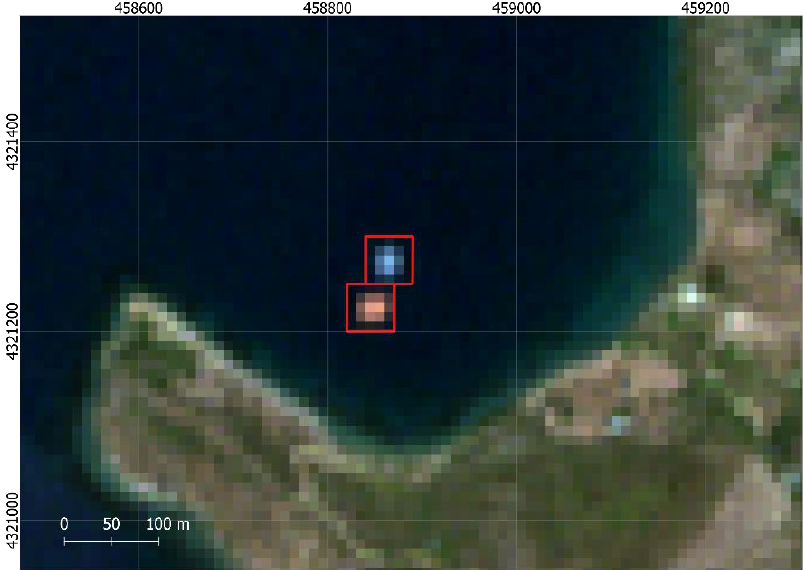
Figure 2. Sentinel-2 cut-out of the PLP2021 deployment area showing the HDPE and wooden planks targets with the corresponding 5 × 5 pixel averages used for spectral analysis. Table 2. Sentinel-2 MSI spectral bands